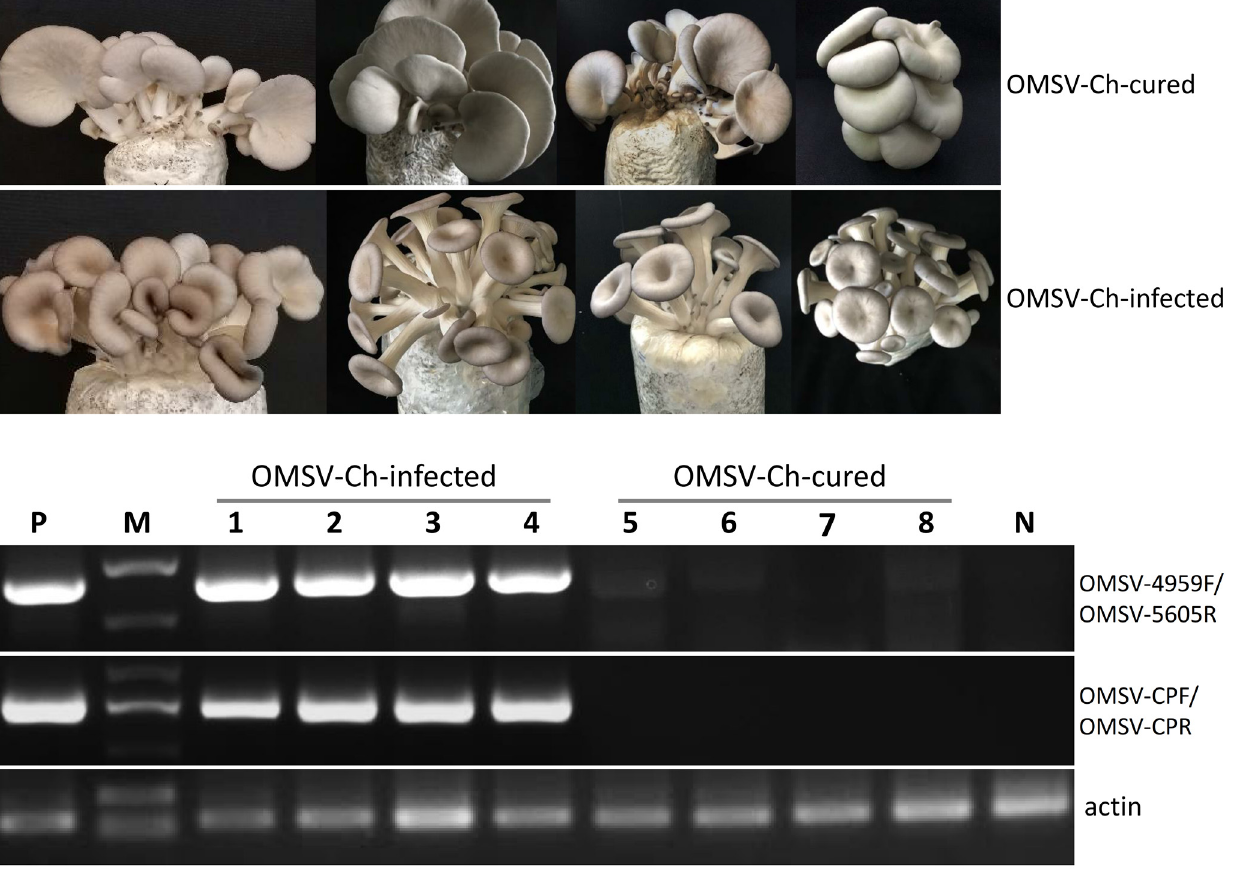
Figure 5. The cultivation test to examine the effects of the OMSV-Ch infection on P. ostreatus fruiting bodies. ( a ) The morphological characteristics of fruiting bodies of the OMSV-Ch-cured (upper panel) and OMSV-Ch-infected (lower panel) strains. ( b ) Semi-quantitative RT-PCR analysis for OMSV-Ch in fruiting bodies of OMSV-Ch-infected and OMSV-Ch-cured strains. Different bags of fruiting bodies were collected from the OMSV-Ch-infected (lanes 1–4) and OMSV-Ch-cured strains (lanes 5–8). The primers OMSV-4959F/OMSV-5605R (upper panel) and OMSV-CPF/ OMSV-CPR (middle panel) were used for RT-PCR detection of OMSV-Ch. Actin served as an internal control (lower panel). N, negative control, the healthy P. ostreatus sample; P, positive control, the OMSV-Ch-infected P. ostreatus sample; M, GL DNA Marker2000. Table 1. Effects of the OMSV infection on the P. ostreatus measured in the cultivation test.